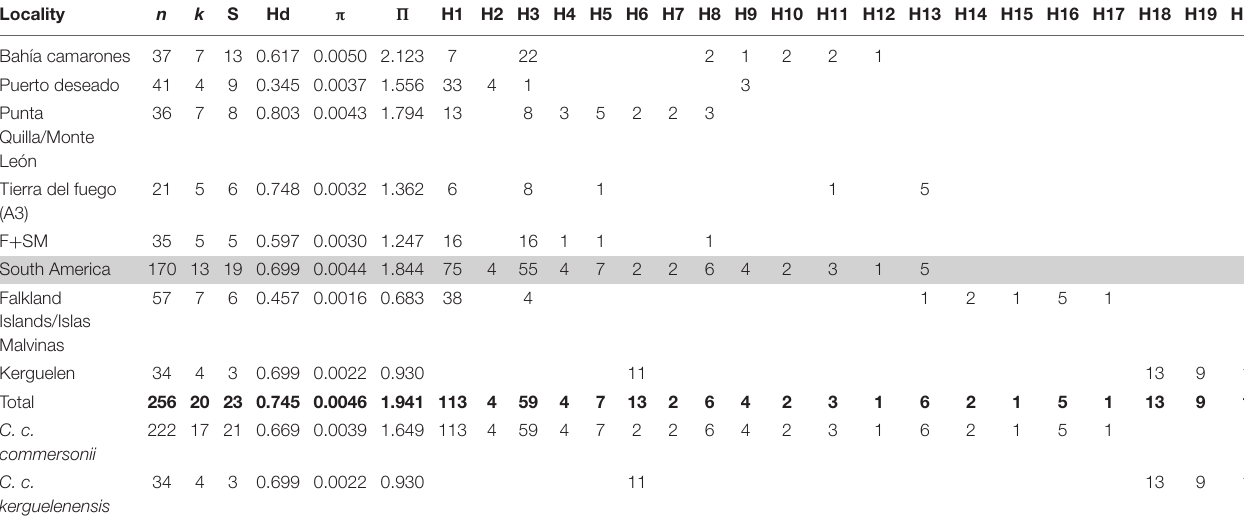
The average values for continental South America are presented in gray. Bold values indicate the total value of each column.